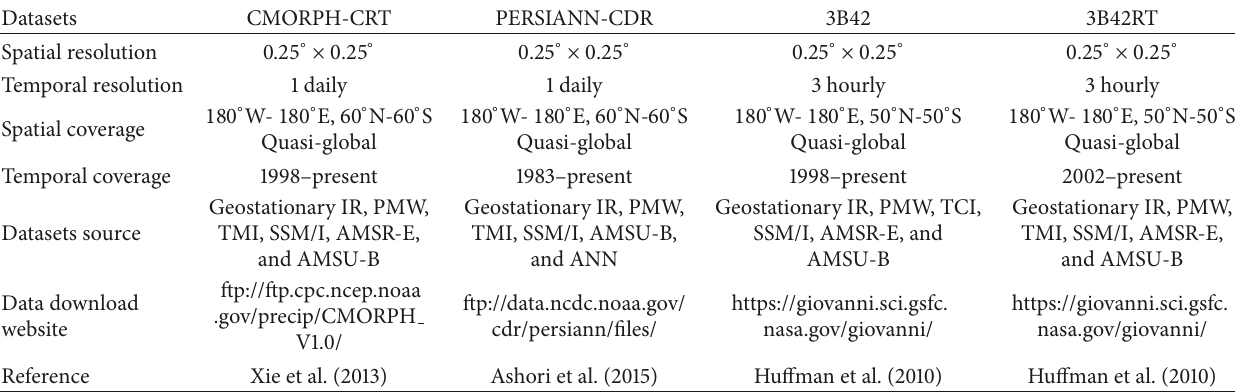
Table 2: Summary of the selected satellite-based precipitation products used in the present